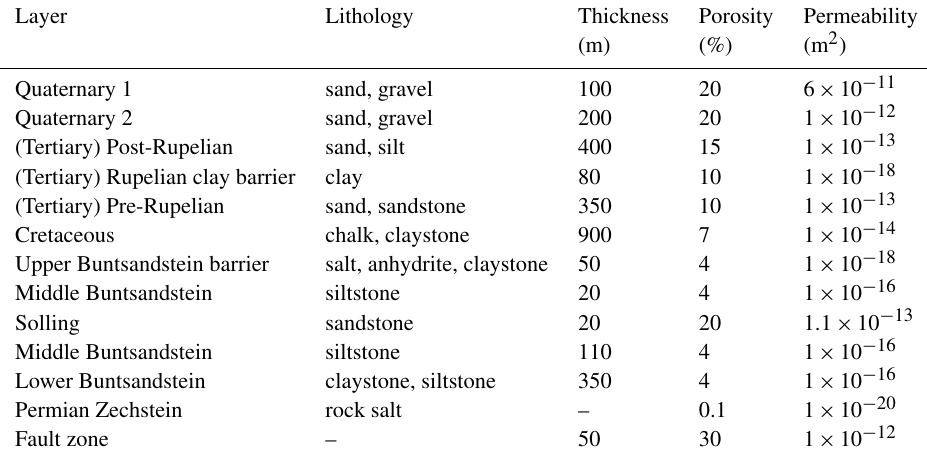
Table 1. Properties of the model layers according to Larue (2010), Reutter (2011), Schäfer et al. (2011), and Noack et al. (2013).